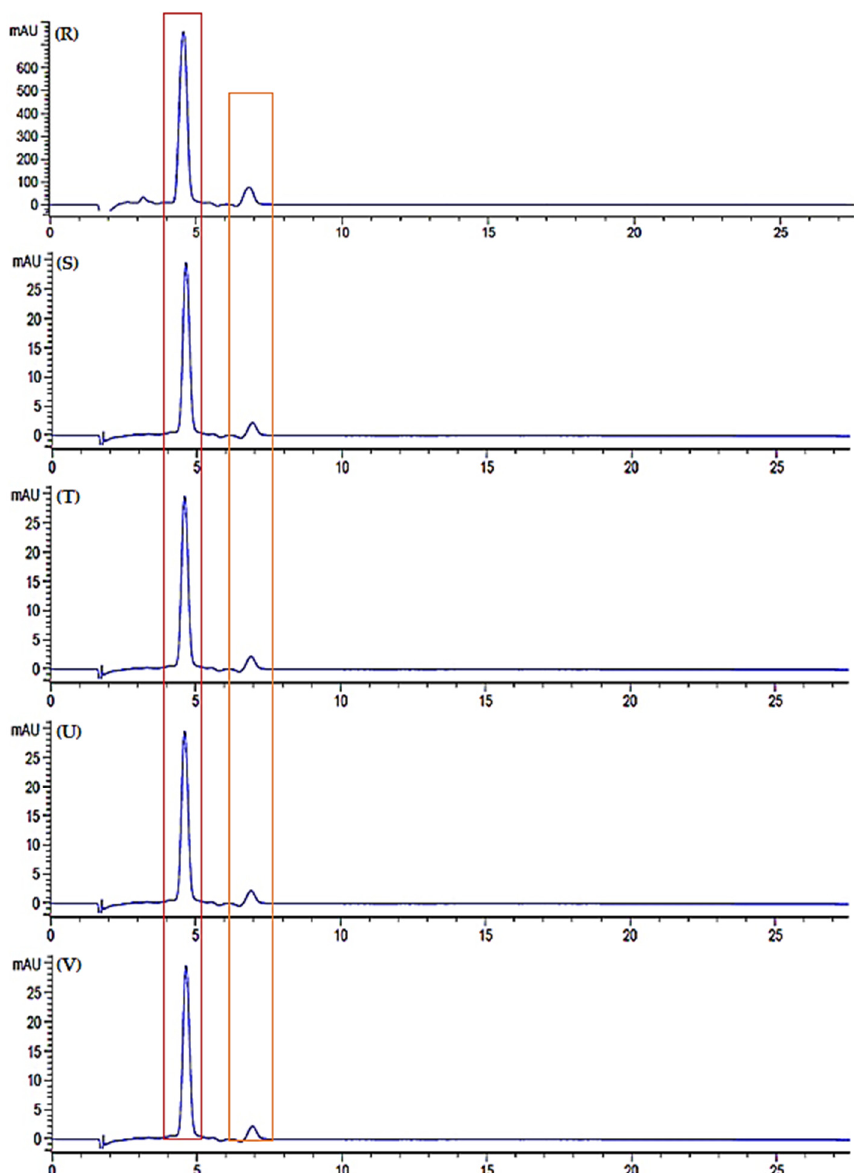
Figure 11. Chromatogram of standard ( A ) lycopene and ( B ) β -carotene, chromatogram of watermelon juice in room temperature storage; fresh juice ( C ), day 3 ( D ), day 5 ( E ), day 7 ( F ) and day 9 ( G ), chromatogram of watermelon juice in refrigerator cold storage; fresh juice ( H ), day 3 ( I ), day 5 ( J ), day 7 ( K ) and day 9 ( L ), chromatogram of watermelon juice in refrigerator freeze storage; fresh juice ( M ), day 3 ( N ), day 5 ( O ), day 7 ( P ) and day 9 ( Q ), chromatogram of freeze-dried watermelon juice; fresh juice ( R ), day 3 ( S ), day 5 ( T ), day 7 ( U ) and day 9 ( V) .